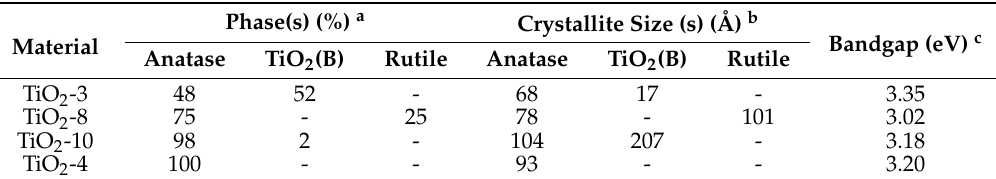
Table 1. Physical properties of mesoporous hard templated TiO 2